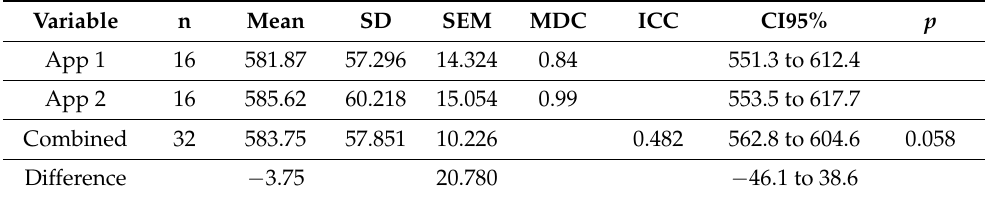
Table 3. Test–retest